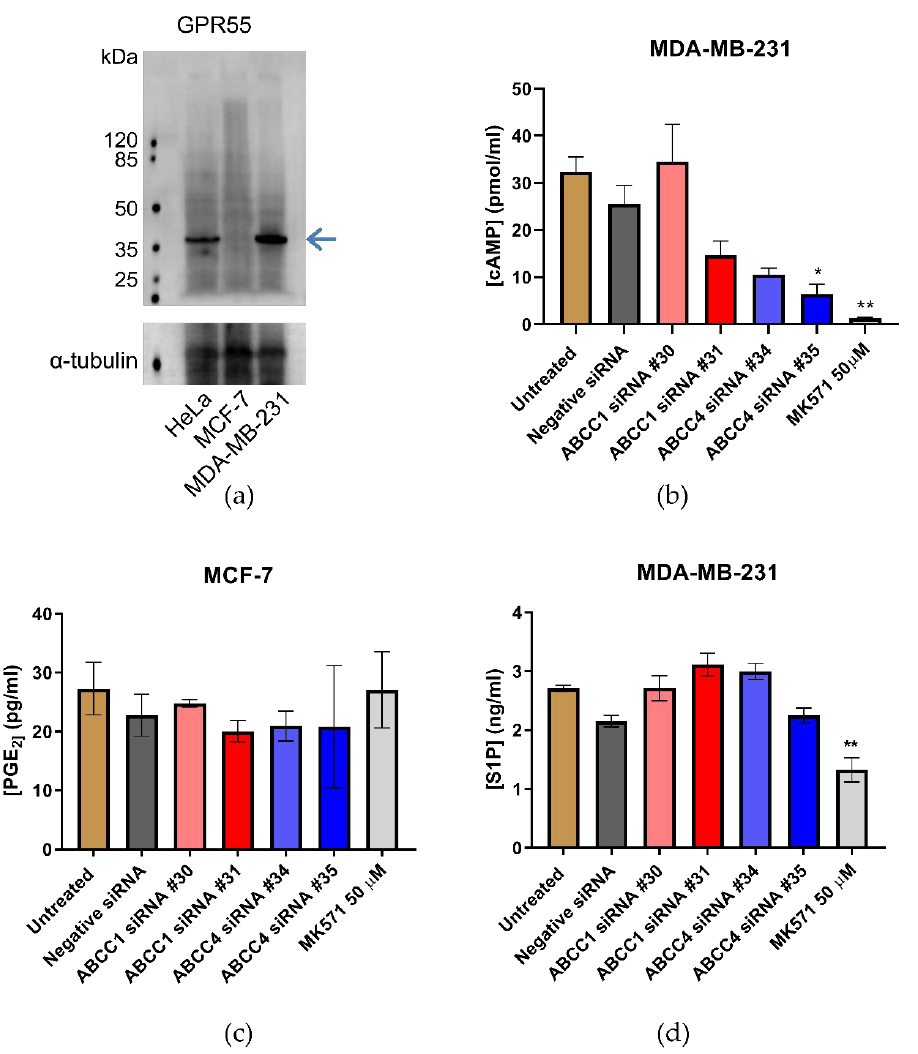
Figure 8. Efflux of cAMP or S1P are possible mechanisms by which ABCC transporters affect breast cancer cells. ( a ) Western blot analysis of the expression of GPR55 in breast cancer cell lines. The blue arrow indicates the band corresponding to GPR55 ( b ) Efflux of cAMP from MDA-MB-231 breast cancer cells was assayed using an ELISA. Data are mean ± sem, n ≥ 2, each in duplicate. ( c ) Efflux of Prostaglandin E 2 (PGE 2 ) from MCF-7 breast cancer cells was assayed using an ELISA. Data are mean ± sem, n ≥ 2, each in duplicate. ( d ) Efflux of S1P from MDA-MB-231 breast cancer cells was assayed using an ELISA. Data are mean ± sem, n ≥ 3, each in duplicate. Data were analyzed by a one-way ANOVA with a Dunnett’s post hoc test. * p < 0.05 and ** p < 0.01, significantly lower than untreated or negative siRNA treatment.